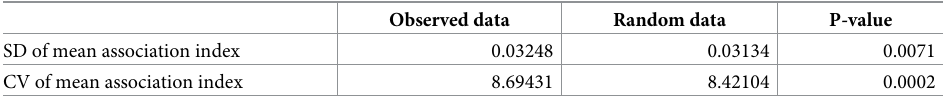
Table 1. Permutation test for preferential association between single day